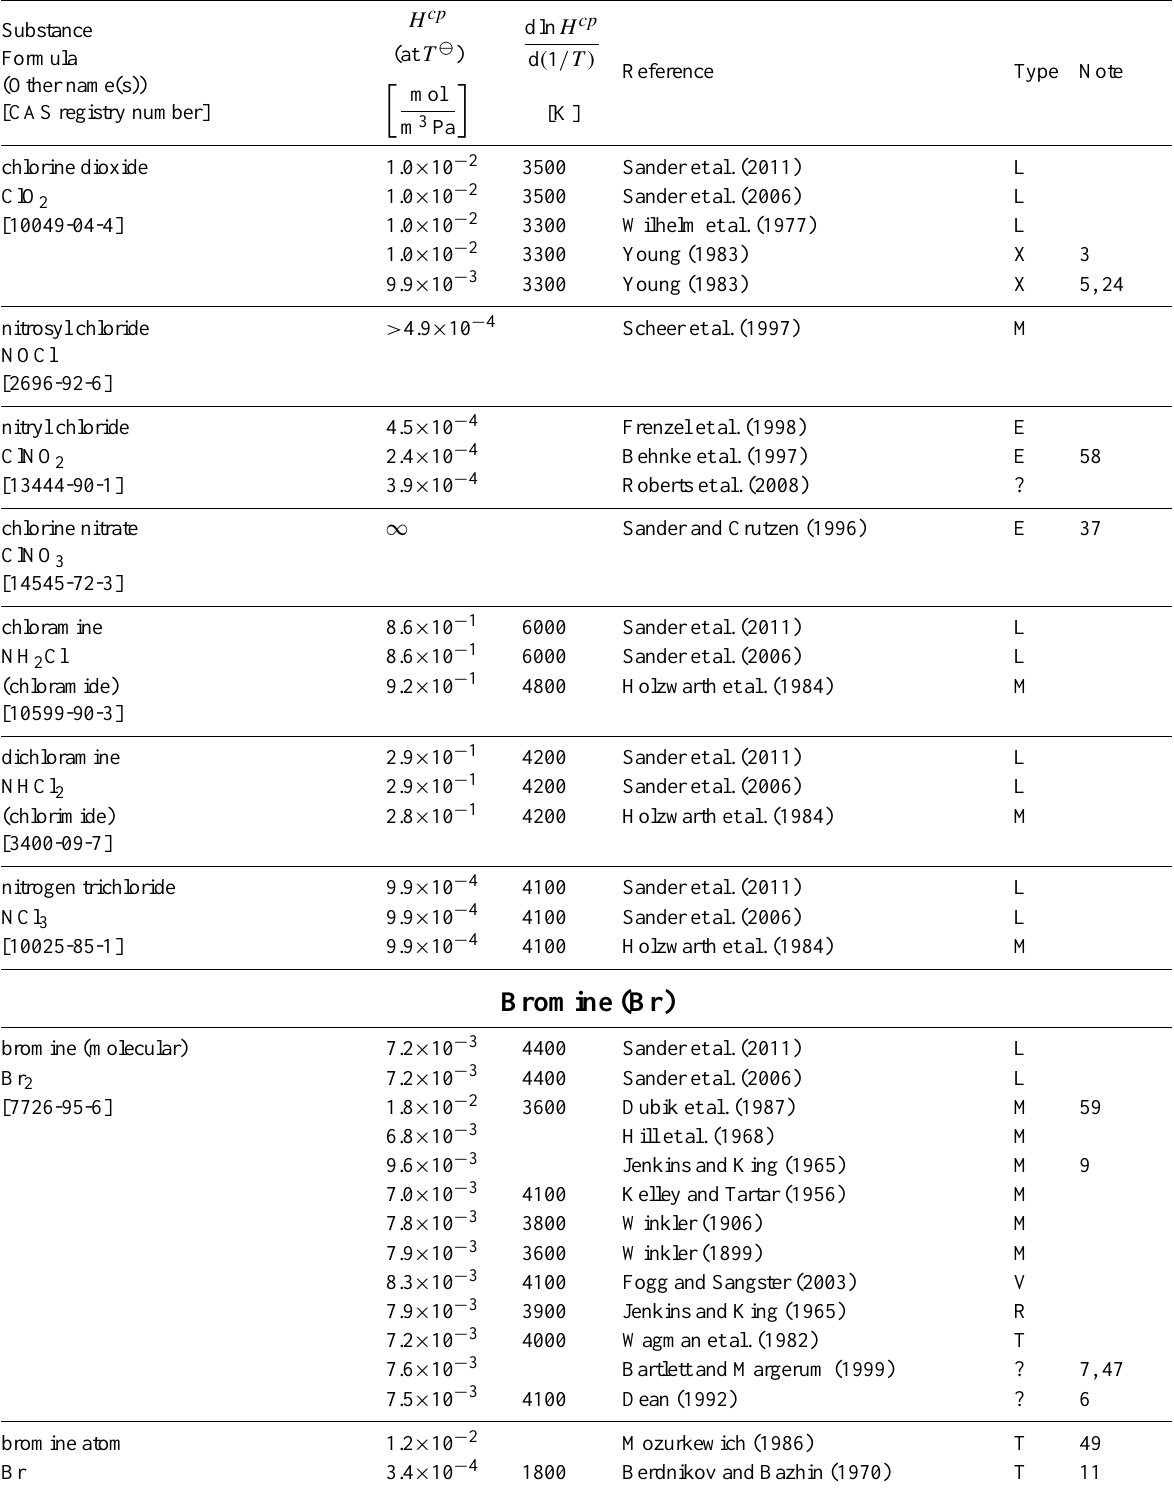
Table 6: Henry’s law constants for water as solvent